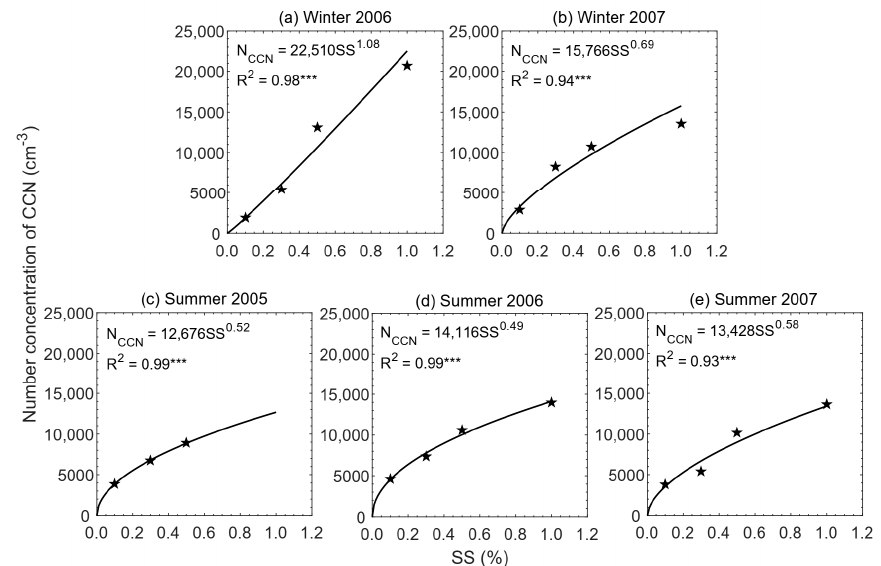
Figure 7. The relationship between N CCN and SS in ( a ) winter 2006, ( b ) winter 2007, ( c ) summer 2005, ( d ) summer 2006 and ( e ) summer 2007. The fitting formulas and the corresponding R–squared (R 2 ) values are marked on the upper left of each graph. Stars and the solid curve in each panel represent the observed data points and the fitted curve of N CCN –SS relationship, with the SS ranging from 0 to 1%. The superscript, ***, indicates that the fitting parameters pass the consistency test under the significance levels of 99%.